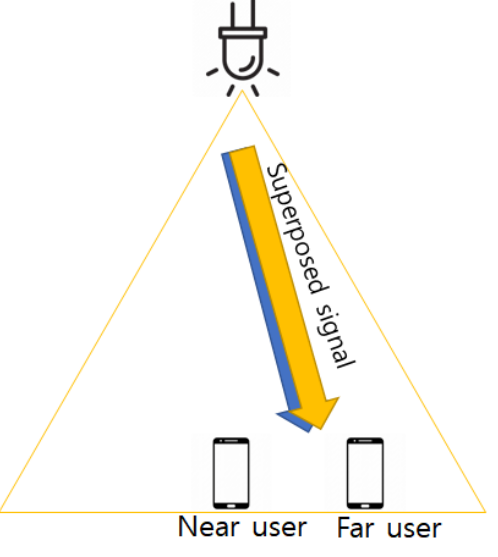
Figure 1. Downlink VLC-NOMA